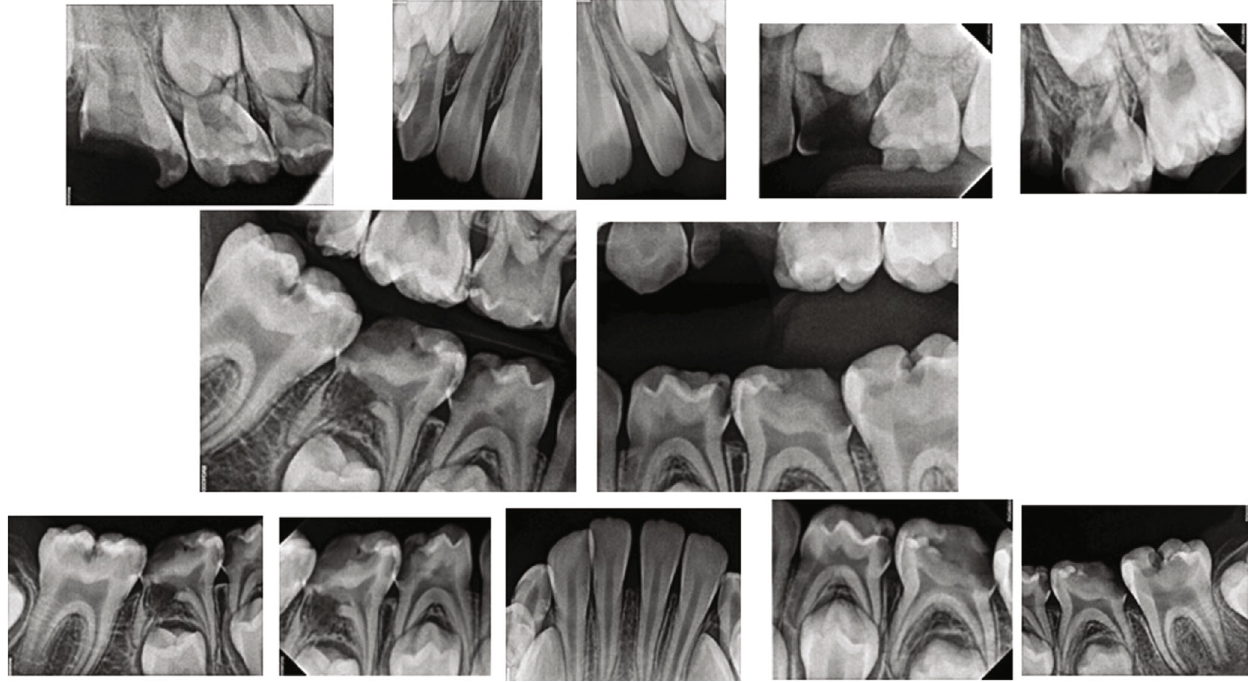
Figure 2: Full mouth preoperative